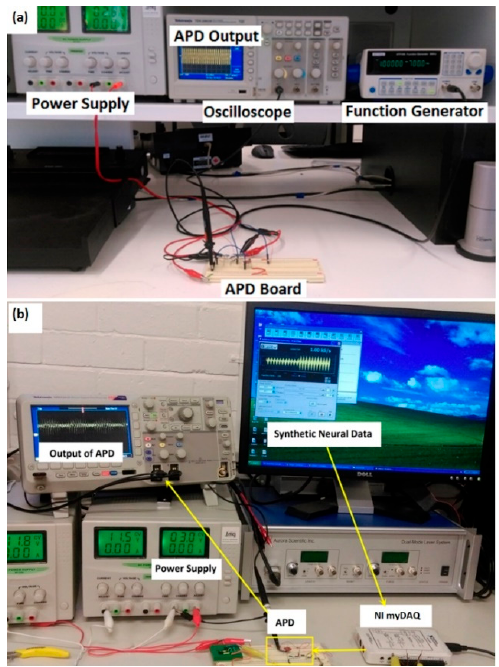
Figure 10. Bench-testing setup for the APD evaluation. ( a ) With sine signal. ( b ) With synthetic neural signal.